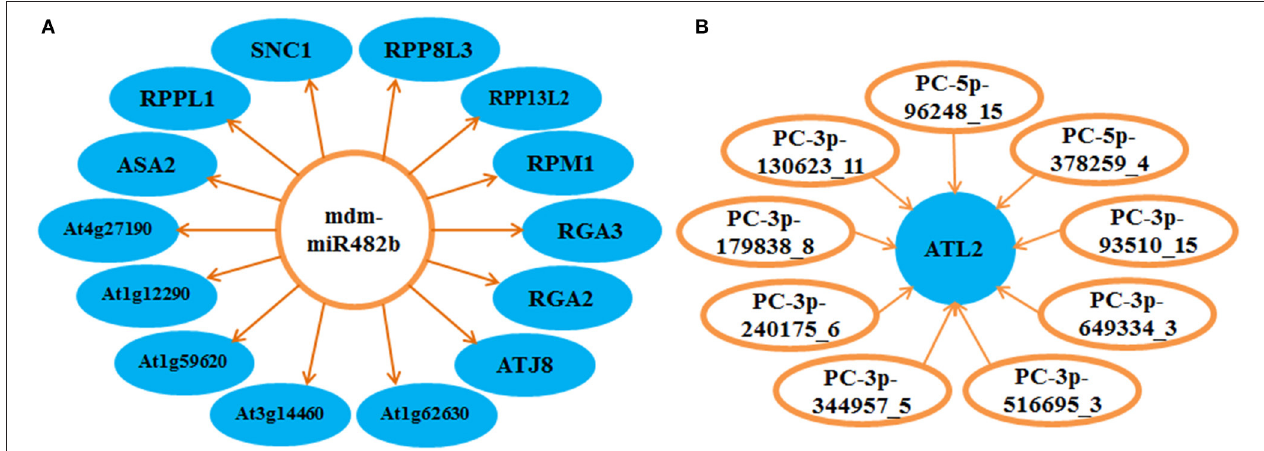
FIGURE 6 | Disease resistance-related regulation network of miRNAs and corresponding targets in the interaction of apple twig bark and V. mali. Several miRNAs and their corresponding targets were selected to show the complex regulation net, and most of them were associated with plant disease resistance. (A) One miRNA was found to be able to regulate several targets. (B) One target could also be regulated by various miRNAs. ATL2, atlastin GTPase 2; ASA2, anthranilate synthase; At1g12290 and At1g59620, probable disease resistance protein; At3g14460 and RPM1, putative disease resistance protein; At1g62630 and At4g27190, disease resistance protein; ATJ8, J proteins; RGA2 and RGA3, Rho-type GTPase-activating protein; RPP13L2, putative disease resistance RPP13-like protein 2; RPP8L3, disease resistance RPP8-like protein 3; RPPL1, putative disease resistance RPP13-like protein 1; SNC1, TIR-NBS-LRR class disease resistance